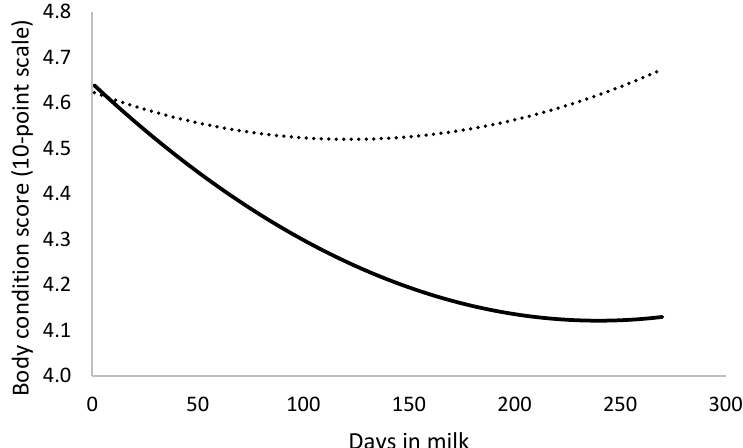
Figure 5. Body condition score of cows milked OAD ( . . . .) and TAD (—) in a 10-point scale during the 2020–2021 production season.